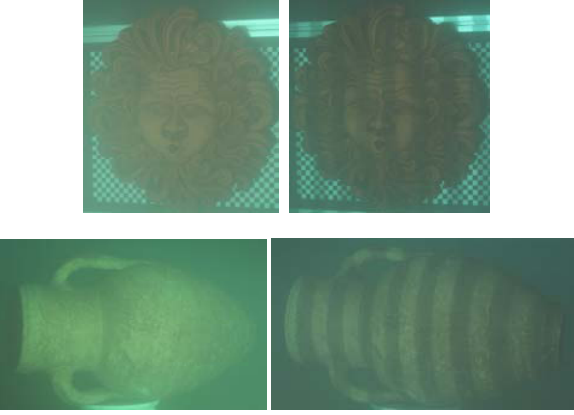
Figure 6. Objects used in the experimentation: an amphora and a mask